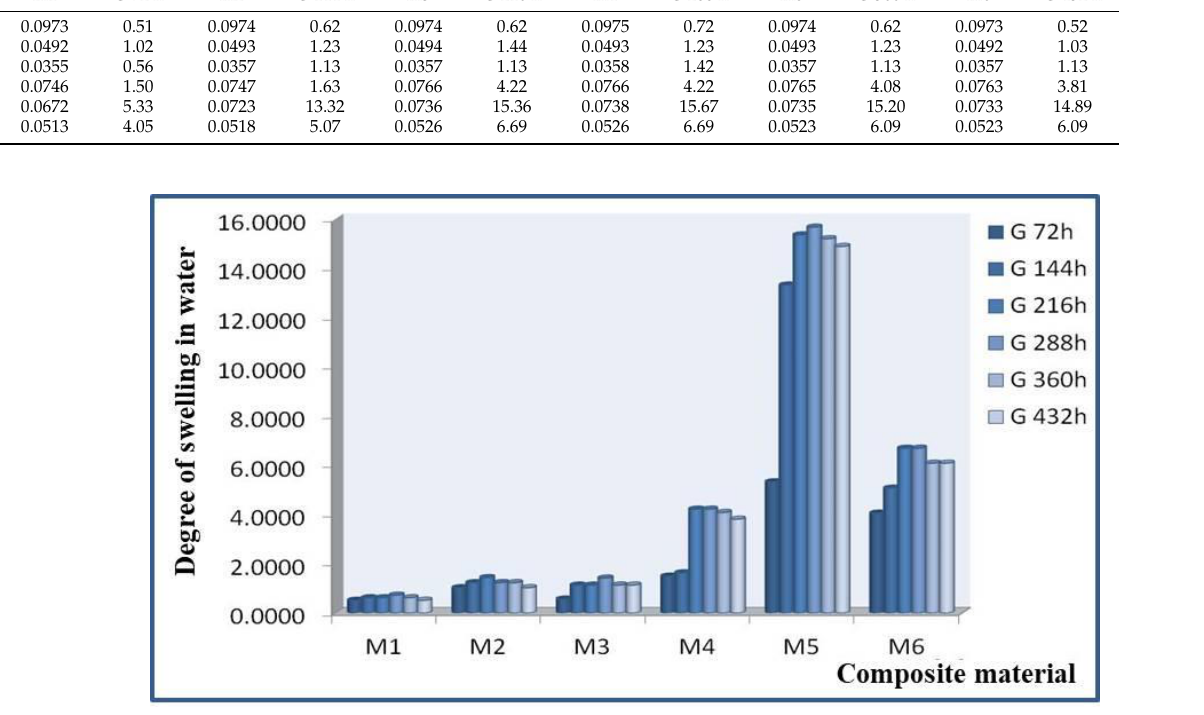
Figure 11. Water swelling of materials M1 – M6.